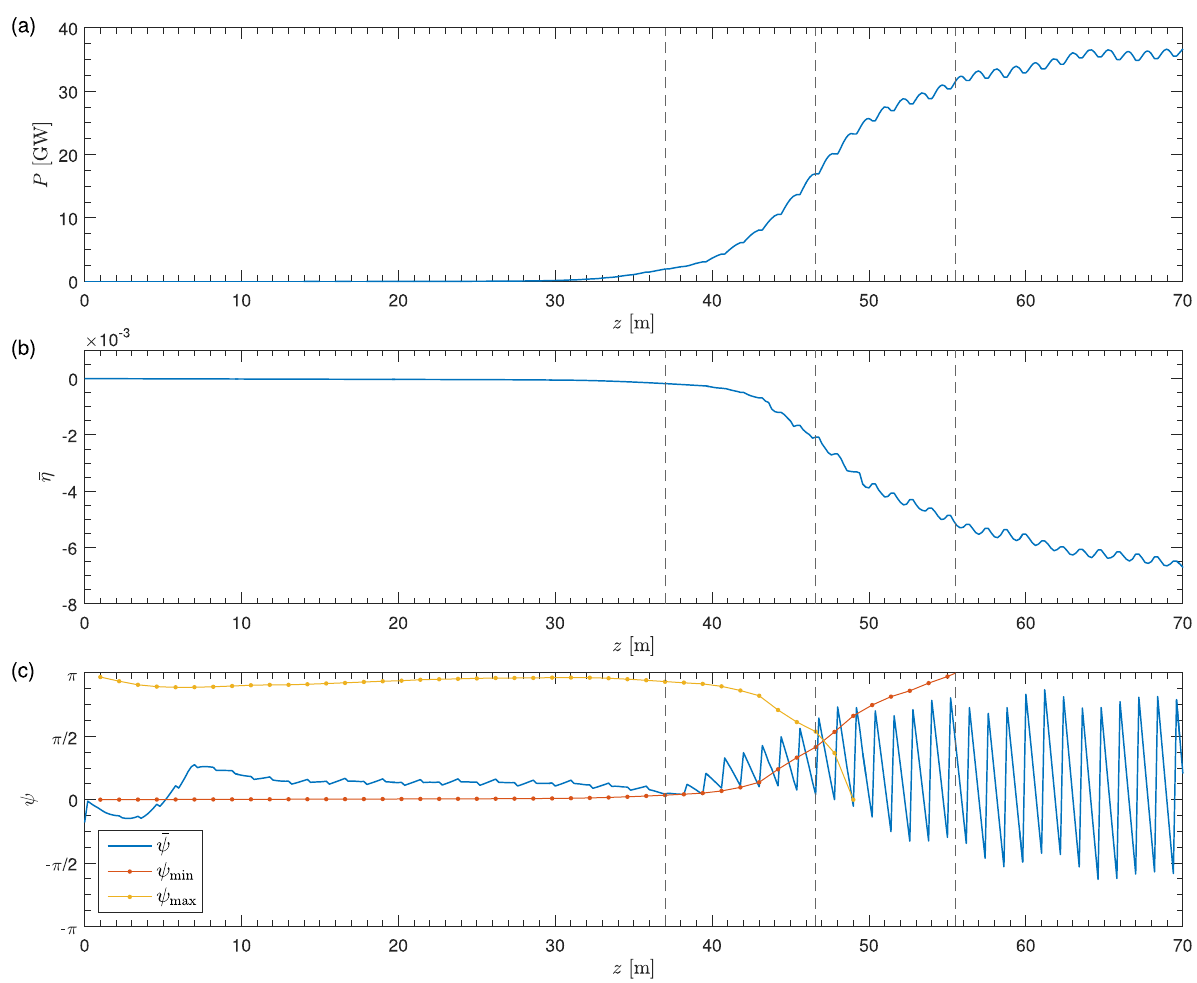
FIG. 5. Result of steady-state simulation. The following quantities are plotted as functions of the distance z along the undulator line: (a) the radiation power, (b) the relative energy deviation ¯ η of the average particle, and (c) the ponderomotive phase ¯ ψ of the average particle (in blue), together with the lower bound ψ (in red) and the upper bound ψ (in yellow) for the target phase ψ in each drift min max targ section. The dashed vertical lines mark the beginning of the in-bucket, out-of-bucket, and final saturation